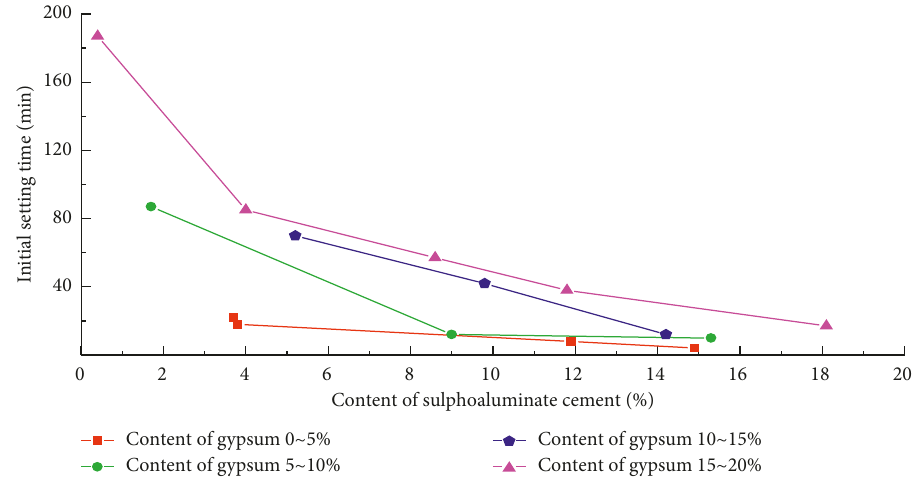
Figure 5: Relationship between initial setting time and components of composite cementing material.